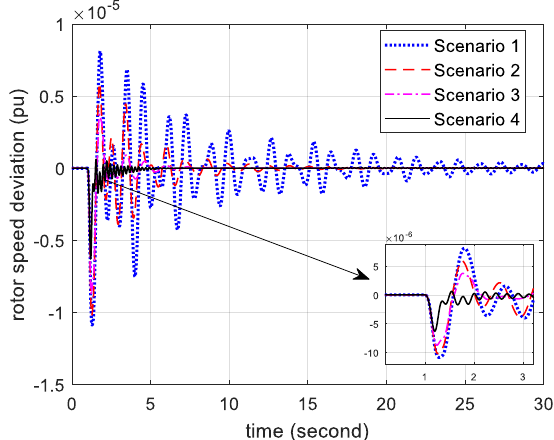
Figure 14. Rotor speed responses of G4 under three-phase fault (Scenario 1: System without BESS; Scenario 2: System with BESS; Scenario 3: System with VISMA-FFO; Scenario 4: System with VISMA -proposed).